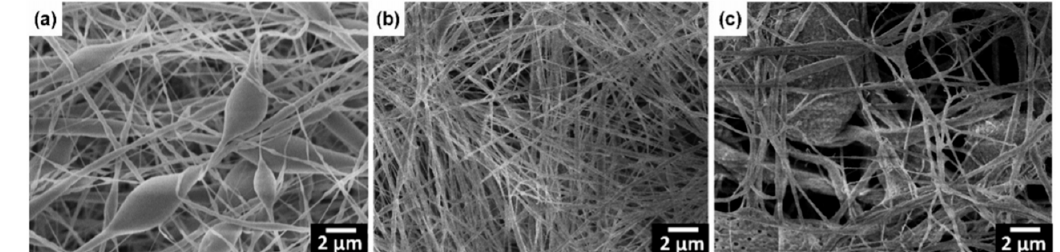
Figure 15. FE-SEM micrographs of the dried electrospun PVDF fibers ( a ) without Al (NO 3 ) 3 · 9H 2 O, ( b ) with 8 wt.% Al (NO 3 ) 3 · 9H 2 O, and ( c ) with 16 wt.% Al (NO 3 ) 3 · 9H 2 O. Reprinted with permission from [123].